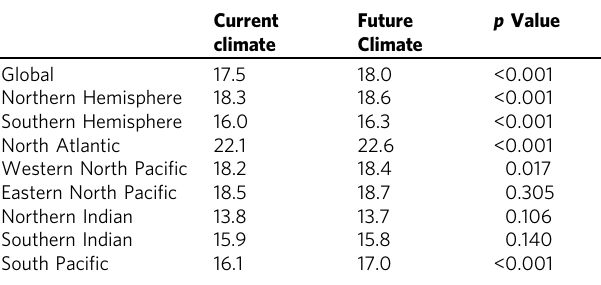
Table 1 Changes in the tropical cyclone translation speed between the current and future climates.